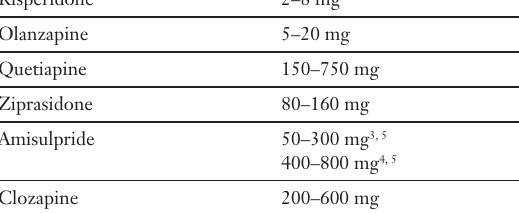
Commonly used daily doses of atypical antipsy- chotics [29]. 1,